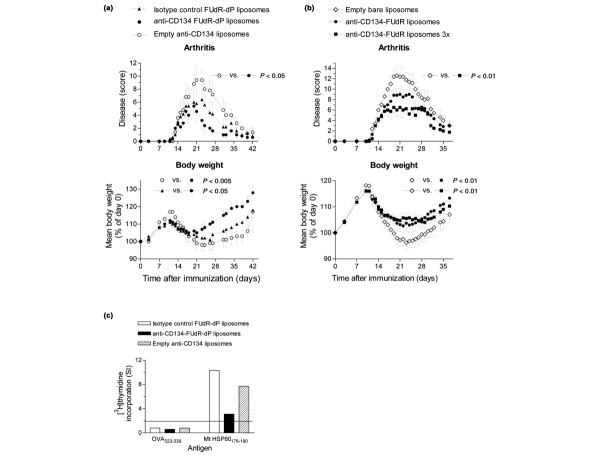
Adjuvant arthritis is modulated by treatment with anti-CD134 5'-fluoro-2'-deoxyuridine dipalmitate (FUdR-dP) liposomes. (a) Rats were immunized with Mycobacterium tuberculosis (Mt) to induce arthritis. On days 3 and 7, rats received isotype control FUdR-dP liposomes (filled triangles), anti-CD134-FUdR-dP liposomes (filled circles), or empty anti-CD134 liposomes (open circles) subcutaneously (s.c.) in both hind paws. (b) Alternatively, after immunization with Mt, on days 3 and 7 rats received anti-CD134-FUdR-dP liposomes (filled circles) or empty bare liposomes (open diamonds), or on days 3, 7, and 10 anti-CD134-FUdR-dP liposomes (filled squares), s.c. in both hind paws. Rats were followed for the development of clinical disease and body weight until the disease resolved spontaneously (day 37 to 42). Results are expressed as the arthritis score and the mean body weight (percentage of day 0) per group of n = 5 rats and are presented as means ± SEM. Statistical differences are indicated in the plots. (c) On day 42, rats shown in (a) were killed; popliteal lymph node cells were isolated and pooled from each treatment group. Cells from isotype control FUdR-dP liposome-treated rats (white bars), anti-CD134-FUdR-dP liposome-treated rats (black bars), and empty anti-CD134 liposome-treated rats (hatched bars) were tested for their proliferative response to 20 μg/ml Mt HSP60176–190 peptide (in which HSP60 stands for heat shock protein 60) in a [3H]thymidine incorporation assay. The proliferation to 20 μg/ml peptide OVA323–339 is shown as a negative control. Results are expressed as the mean SI for quadruple wells. The cut-off value for proliferation was set at SI 2 (indicated by line).